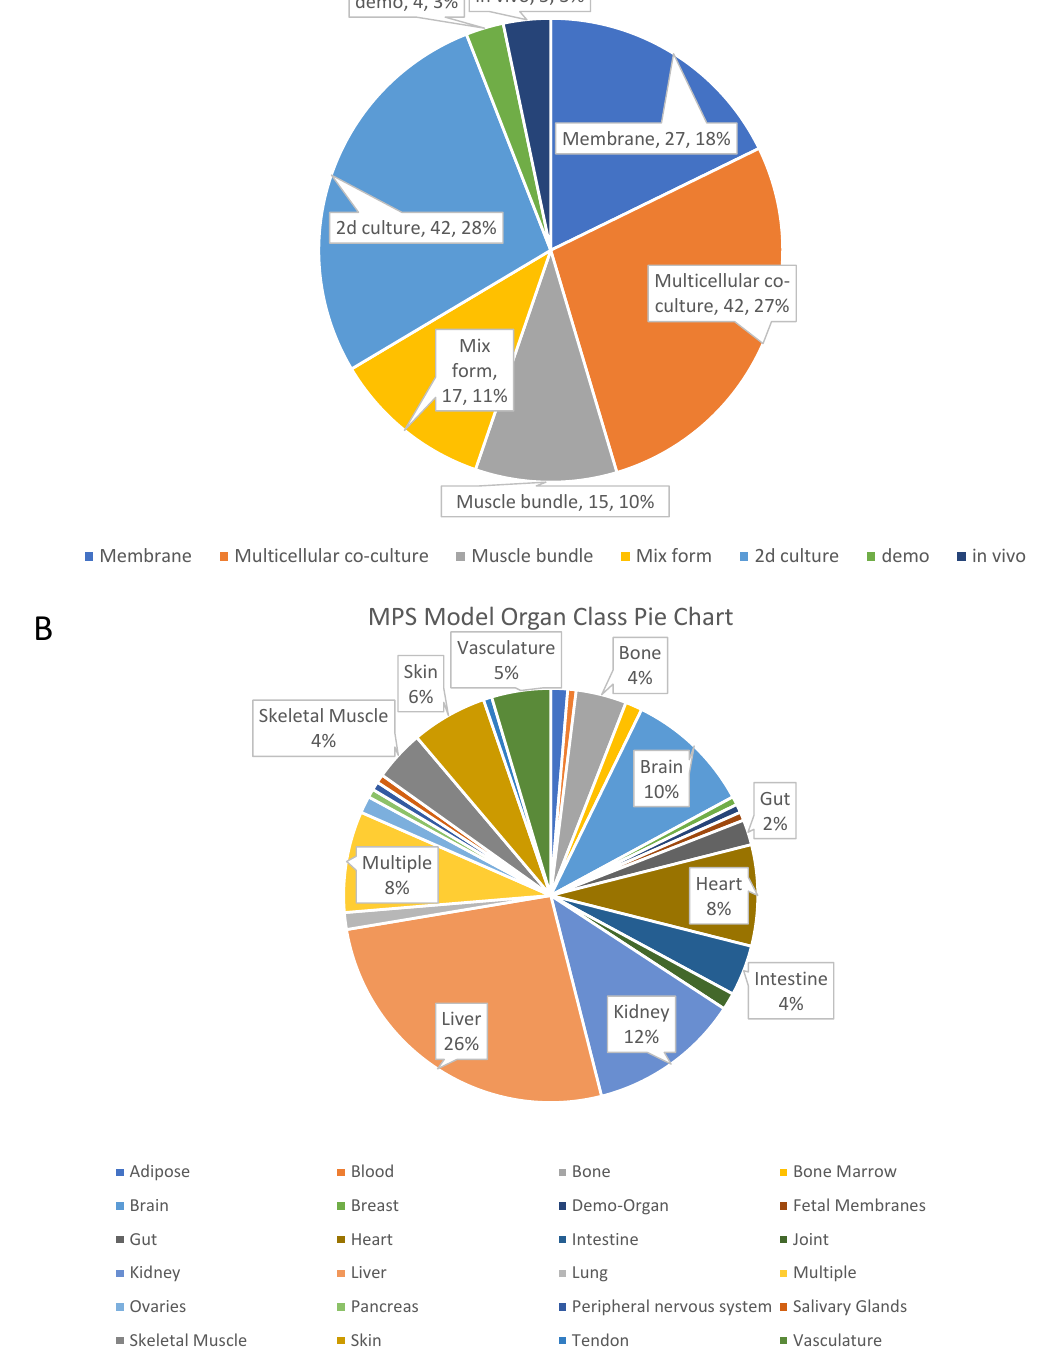
Figure 6. Pie charts of public MPS model data in BAP. ( A ) Pie chart of MPS model according to simulation mode classification. In order to be used as a control group in the study, the BAP has 28% of the total number of two-dimensional culture models. In addition, there is a small number of demos for demonstrating the function of the website. Among the four simulation modes, the multicellular co-culture mode accounts for the largest number. ( B ) Pie chart of MPS model according to organ classification. Classified by simulated organs, there are 24 types of public OOC models, of which the largest proportion is the liver-on-chips with 26%, and the second largest proportion is the kidney-on-chips with 12%. The percentage of organs that did not display data labels is